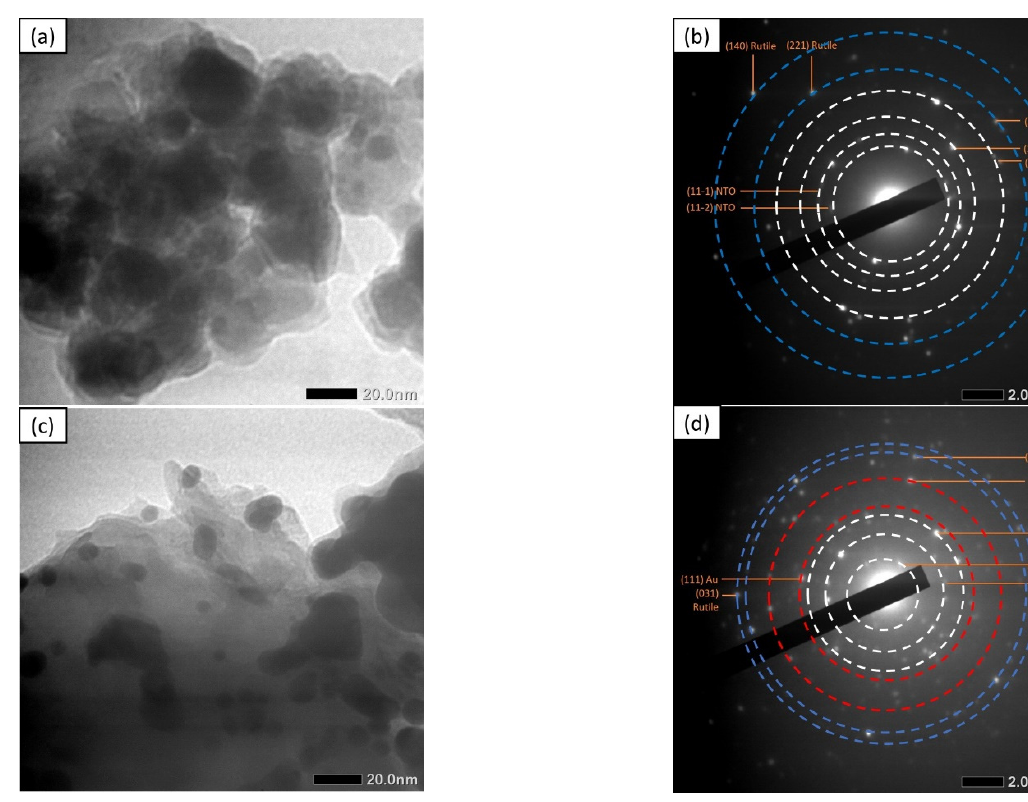
Figure 5. ( a ) TEM image and ( b ) SAED pattern of TiO 2 /NTO, ( c ) TEM image and ( d ) SAED pattern of Au/TiO 2 /NTO.